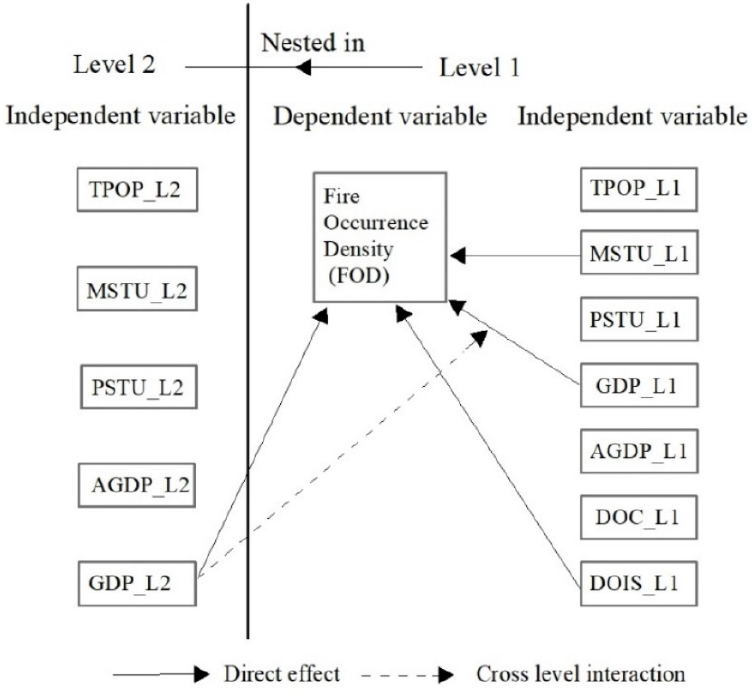
Figure 3. Multilevel structure of the relationship between fire occurrence density and two-level variables.